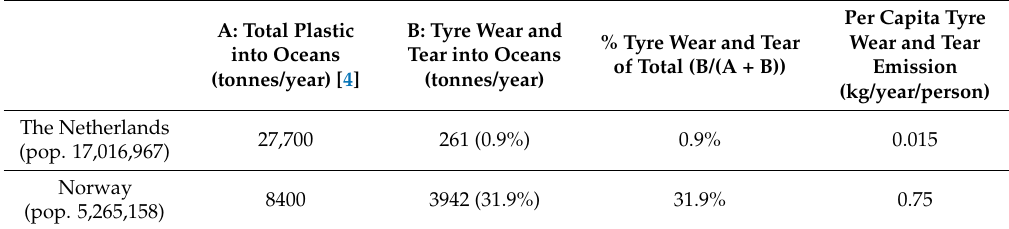
Table 15. The amount of wear and tear of car tyres compared to the total amount of plastics entering the oceans by land (pop. = population as per July 2016